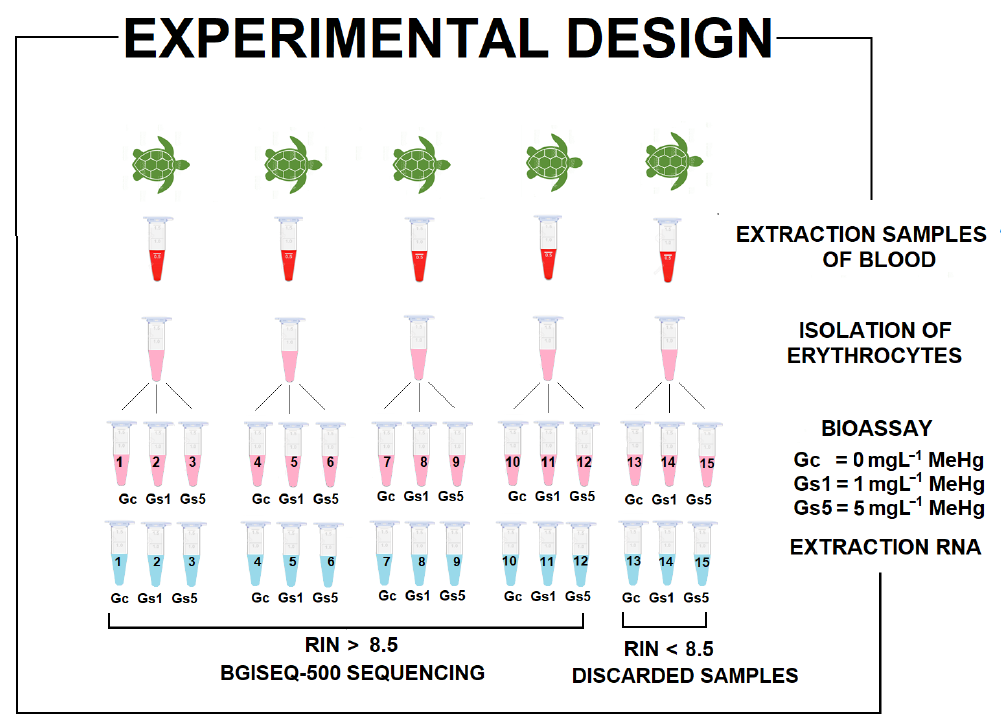
Figure 1. Experimental design. Five steps were carried out prior to sequencing by RNA-seq: (1) samples were obtained from five Caretta caretta turtles; (2) erythrocytes were isolated; (3) the bioassay was carried out; (4) RNA was extracted; and (5) samples were selected for sequencing according to the RNA integrity number (RIN).